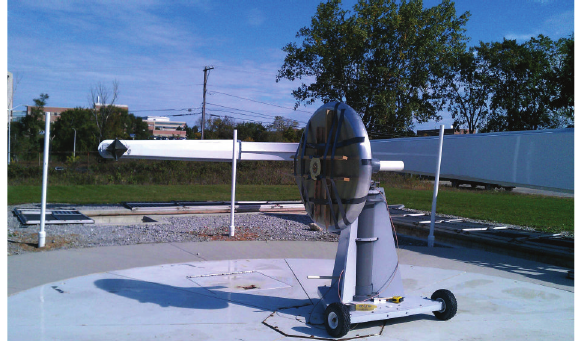
Figure 5: Antenna range at Oakland university.